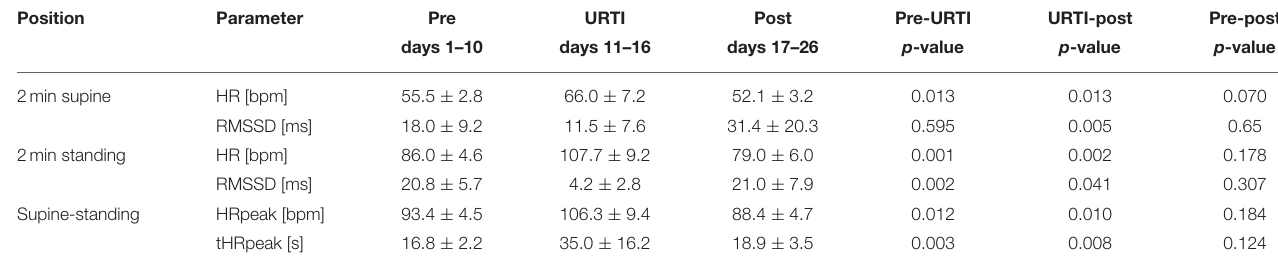
TABLE 1 | Values (mean ± SD) of HR, RMSSD, HRpeak, and tHRpeak (time from HR in the supine position until HRpeak in the standing position) in the orthostatic test (OT) 10 days before, during, and 10 days after the upper respiratory tract infection (URTI) from a 30-year-old elite marathon runner.